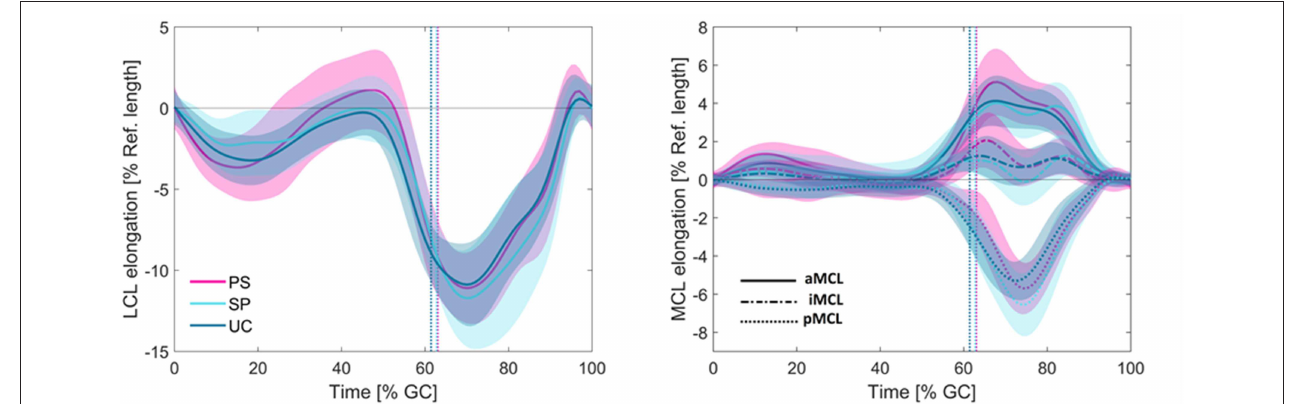
FIGURE 5 | Average elongation patterns for the LCL (left) and MCL (right) during level walking. The vertical dotted lines represent the average toe-off times for the three groups. Solid lines represent inter-subject means and shadings represent ± SDs.